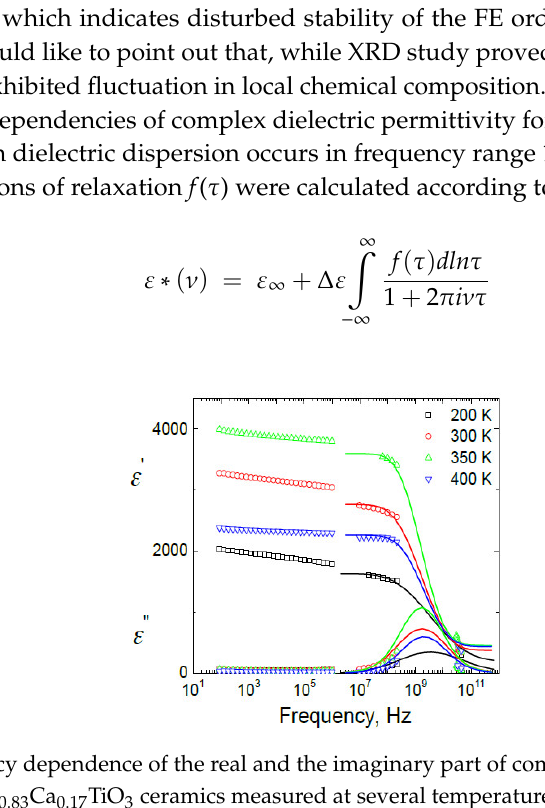
Figure 4. Frequency dependence of the real and the imaginary part of complex dielectric permittivity ε* = ε’ − i ε” for Ba 0.83 Ca 0.17 TiO 3 ceramics measured at several temperatures. The lines denote the best fit according to Equation (1).